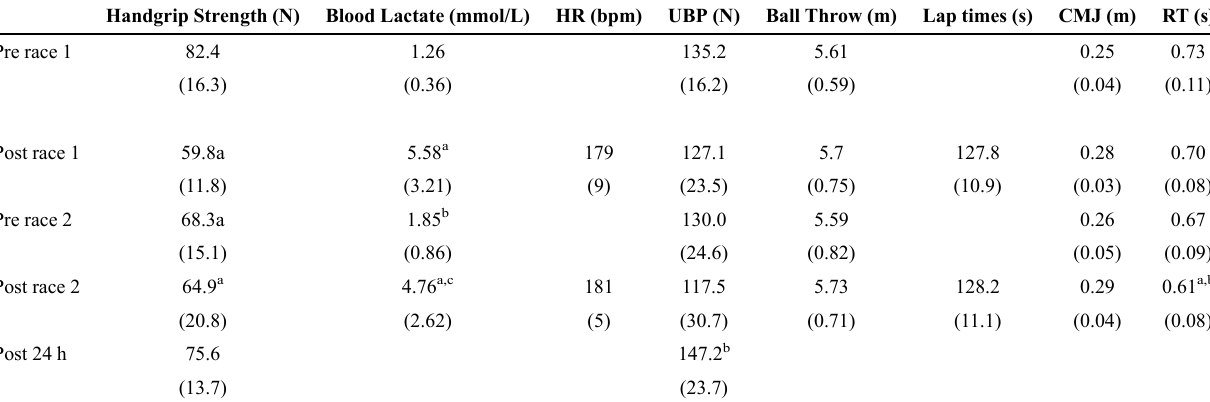
Table 2 - Test results before (Pre) and after (Post) two motorcycle races separated by an active recovery protocol. Data are shown as mean (standard deviation). Handgrip Strength